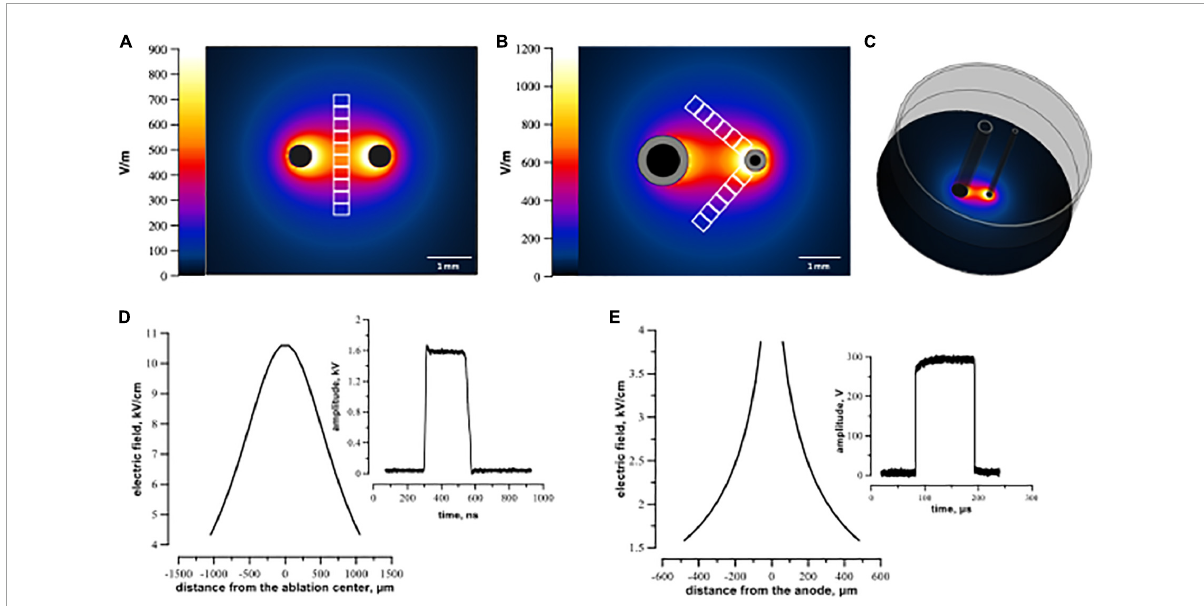
FIGURE1 Electric field simulation for symmetric (A,D) and asymmetric (B,C,E) electrode arrays. Panels (A,B) visualize the calculated electric field distribution with 1 V applied between the electrodes. The direction in which the electric field thresholds were measured is indicated by white rectangles representing regions of interest (see text). Panel (C) illustrates a 3D configuration of the asymmetric electrode assembly orthogonal to the plastic well. Panels (D,E) show the electric field values for 300 V (100 µ s pulse) and 1.74 kV (300 ns pulse) applied between electrodes. Distance from the ablation center (D,E) was measured along the regions of interest from the center of ablation (the middle of the line connecting centers of the electrodes) for symmetrical electrodes (D) and from the middle of the anode for the asymmetrical electrode (E)